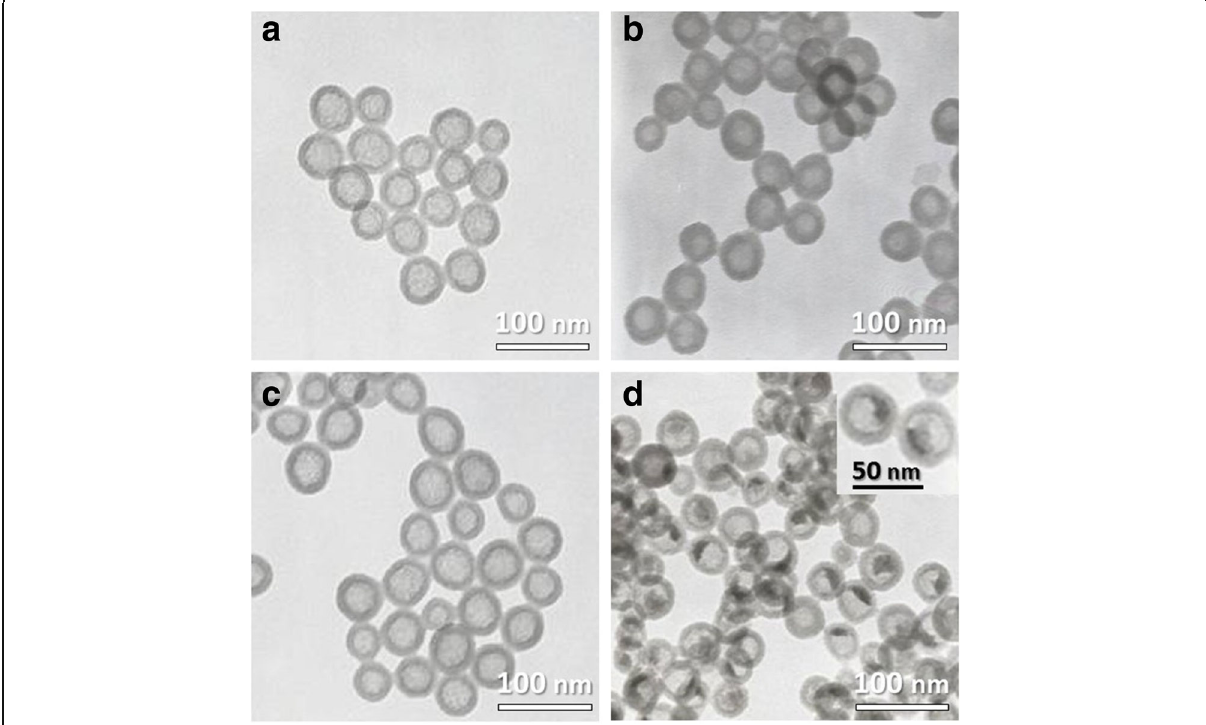
Fig. 1 TEM images of a hollow silica nanospheres (HSNs), b HSNs stained with uranyl acetate, c horseradish peroxidase-encapsulated HSNs (HRP@HSNs), and d HRP@HSNs stained with uranyl acetate. Inset: an enlarged